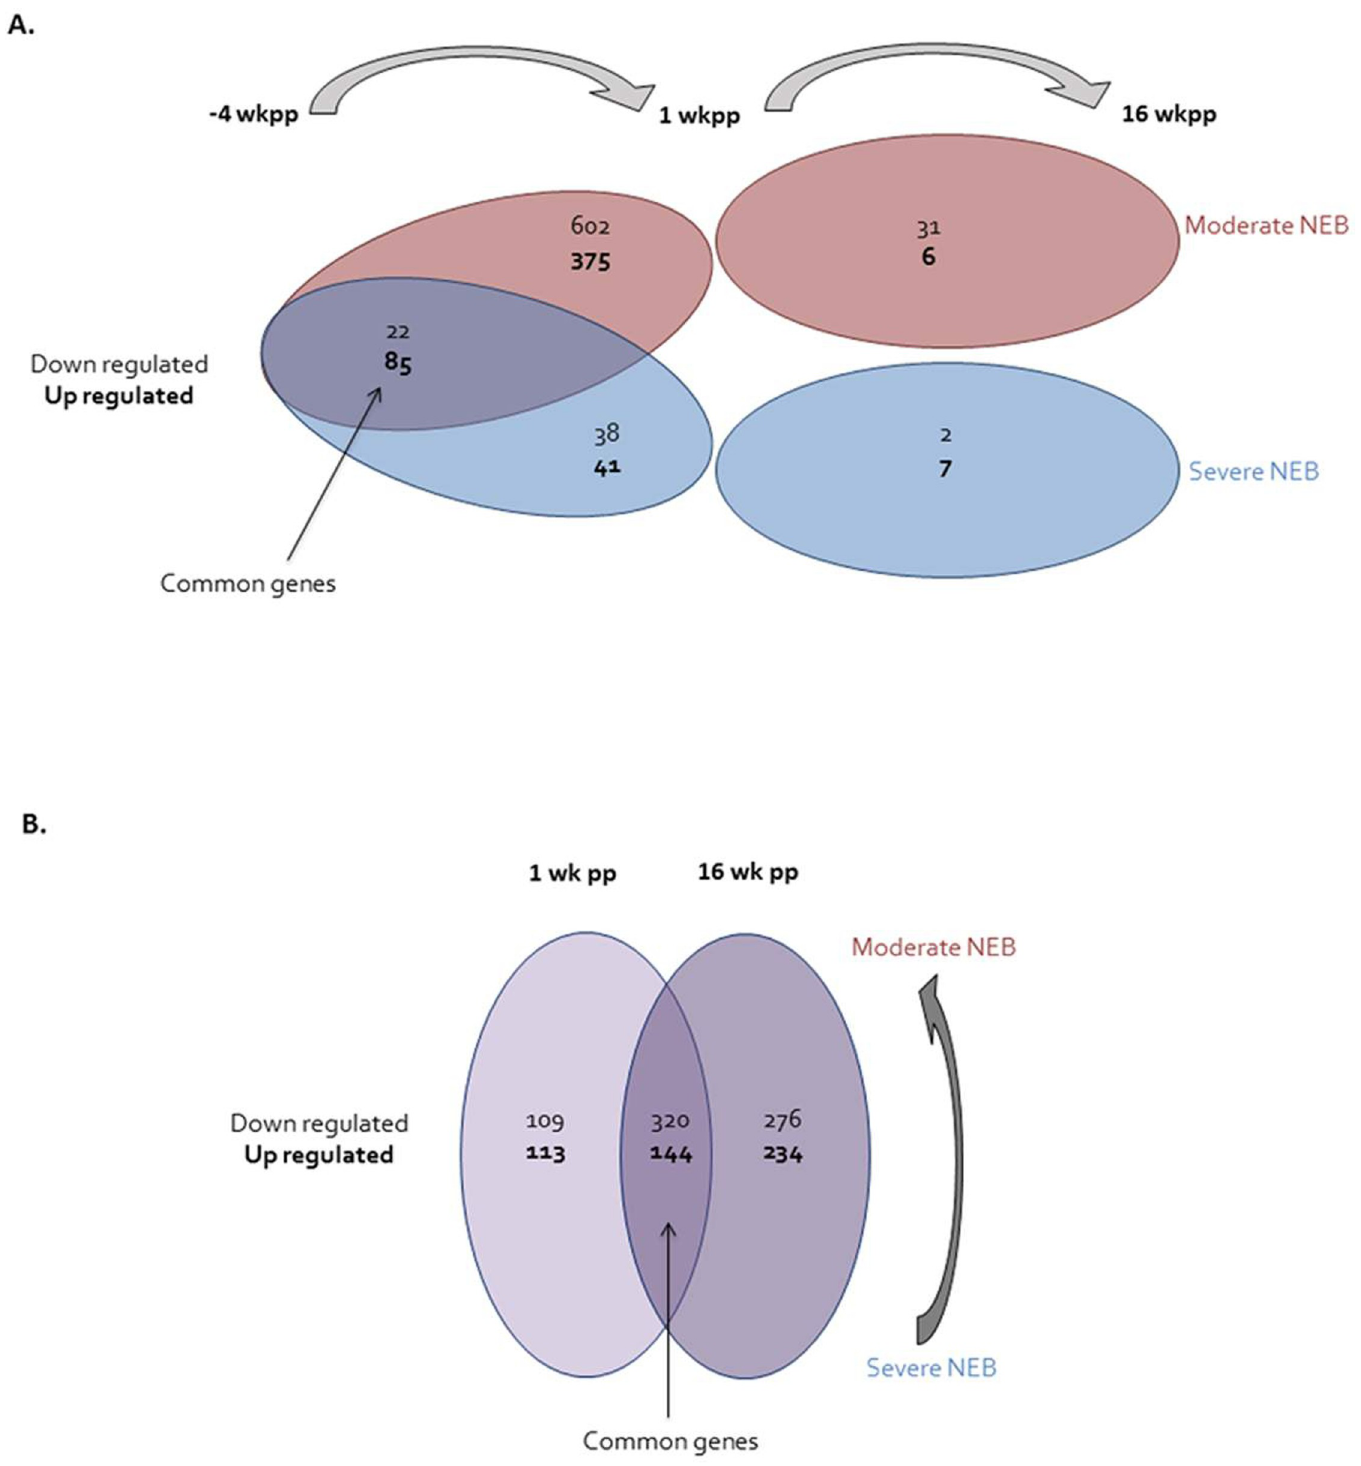
Fig 1. Venn diagram representation of gene differentially expressed according to the time of lactation (-4, 1 and 16 weeks peripartum) (A) or the status of the negative energy balance (moderate and severe negative energy balance) (B). wkpp: weeks peripartum; NEB: negative energy balance.